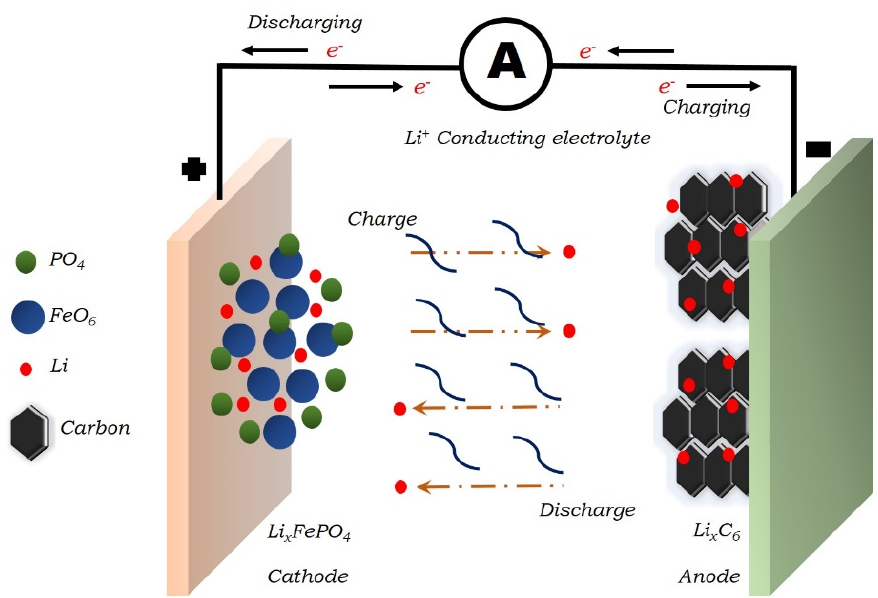
Figure 1. Schematic diagram of Li-ion batteries.